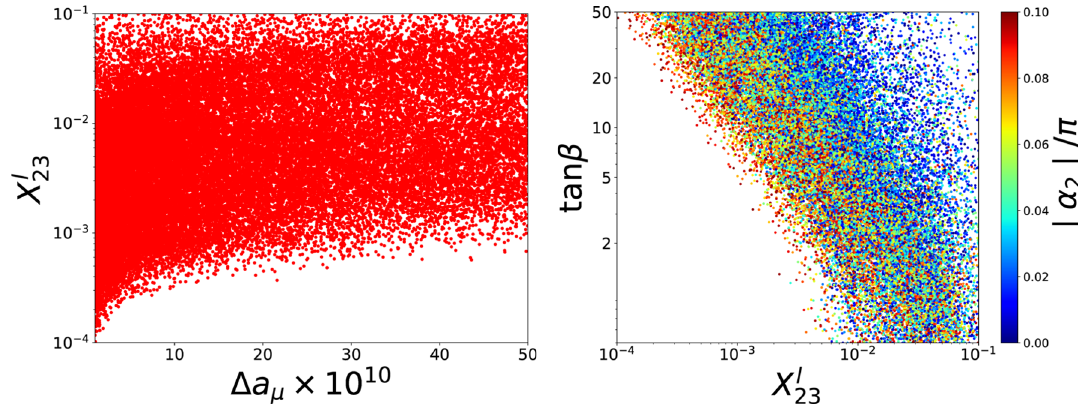
Figure 5 . The allowed parameter regions satisfying the muon g − 2 value within 1 × 10 − 10 < ∆ a µ < 50 × 10 − 10 , for X l = X l 32 23